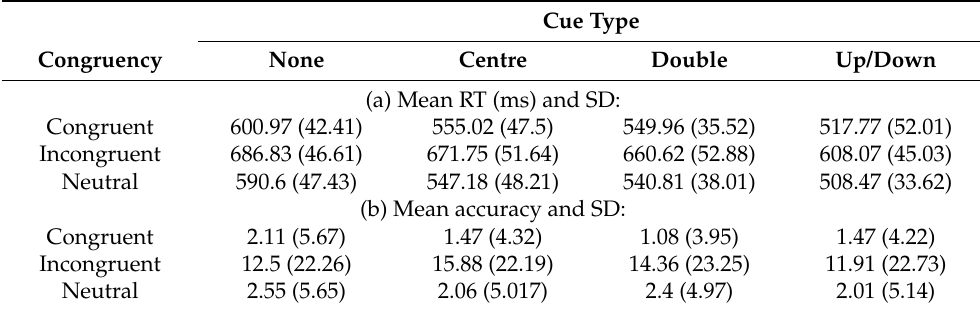
Table 2. Reaction times (RT) and accuracy mean and standard deviation (SD) in milliseconds (ms) for each ANT condition.